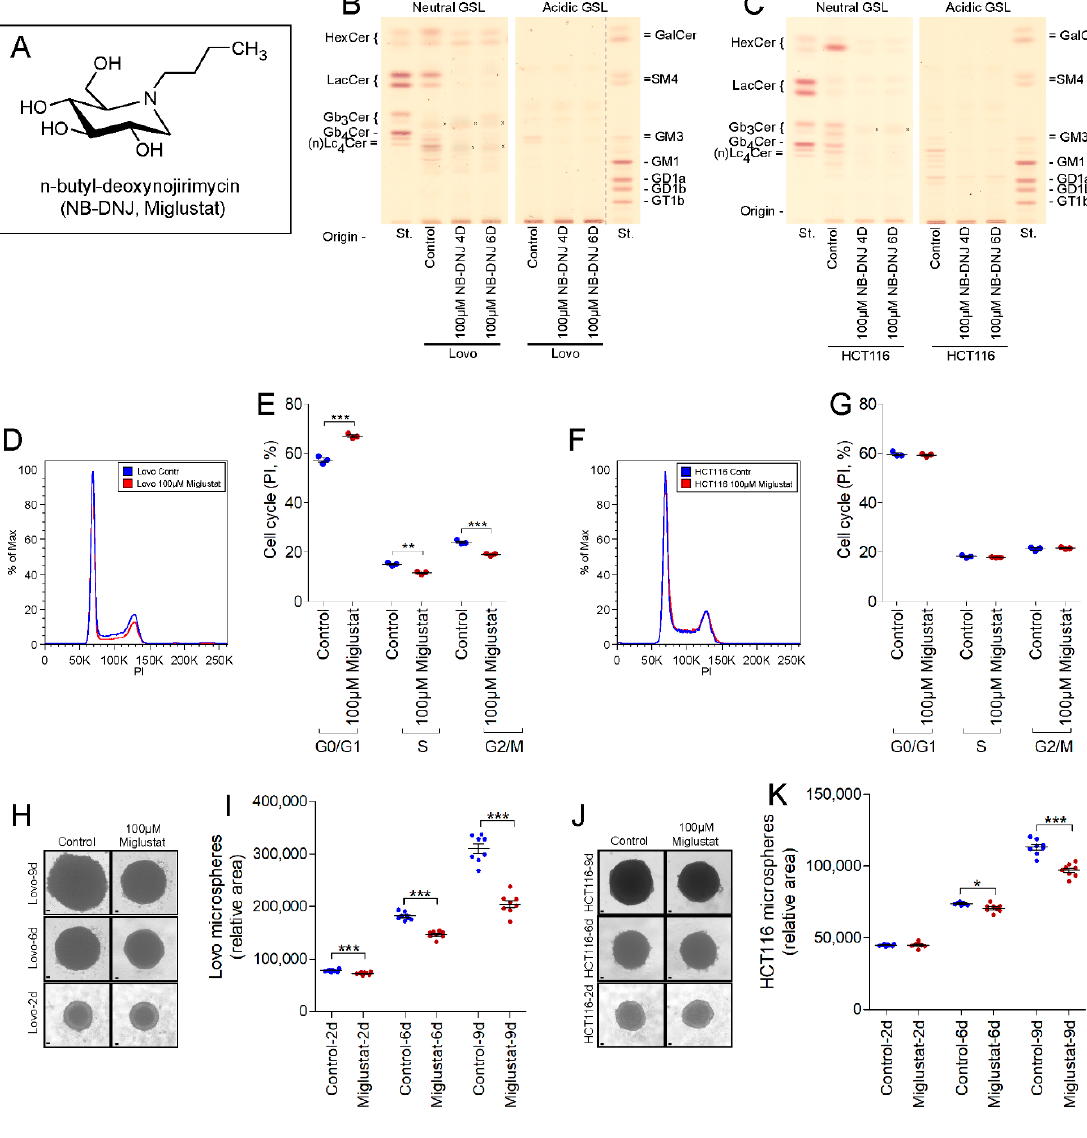
Figure 3. Miglustat treatment leads to cell cycle arrest in Lovo cells and inhibits growth of Lovo and HCT116 tumor spheroids. ( A ) Formula of Miglustat. ( B , C ) n-butyl-deoxynojirimycin (NB-DNJ, Miglustat) inhibits GSL-synthesis of Lovo ( B ) and HCT116 cells ( C ) almost completely after four days; x, no GSL-positive band; running solvent for neutral- and acidic GSLs was CHCl 3 /CH 3 OH, 0.2% CaCl 2 , 60:35:8 ( v / v ). ( D , E , quantification) Miglustat treatment led to a visible arrest of the cell cycle in Lovo cells but not in HCT116 cells ( F , G , quantification). ( H – K ) Miglustat inhibited tumor spheroid growth of Lovo- ( H , I , quantification) and HCT116 cells ( J , K , quantification); each data point on the graphs represents one biological replicate; scale bars, 100 µ M; significances are *, p ≤ 0.05; **, p < 0.01; ***, p <